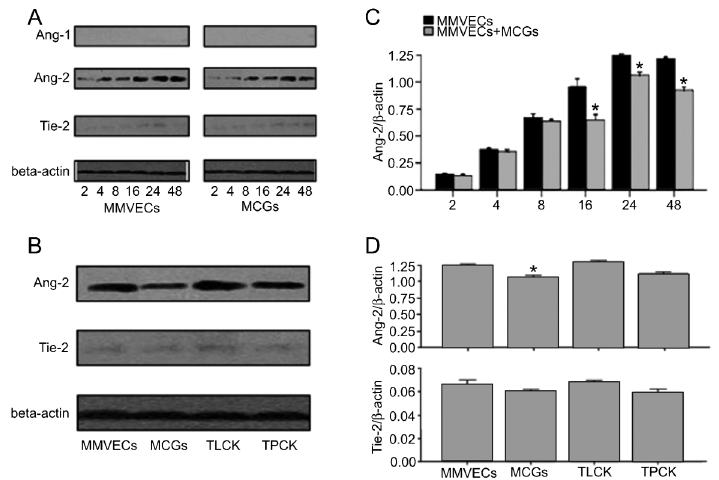
Figure 4. Ang-1, Ang-2 and Tie-2 protein expression in MMVECs. A , C , Tie-2 had no obvious change. Ang-1 was not expressed in MMVECs. Ang-2 decreased significantly in MMVEC with MCGs compared to MMVECs from 16 h (*P , 0.05, Student-Newman-Keuls test). B , D , Expression of Ang-2 increased in the presence of TLCK or TPCK, especially of TLCK. Ang: angiopoietin; MMVECs: myocardial microvascular endothelial cells; MCGs: mast cell granules; TLCK: N -tosyl-L-lysine chloromethyl ketone; TPCK: N -tosyl-L-phenylalanyl chloro- methyl ketone. *P , 0.05 vs MMVECs (Student- Newman-Keuls